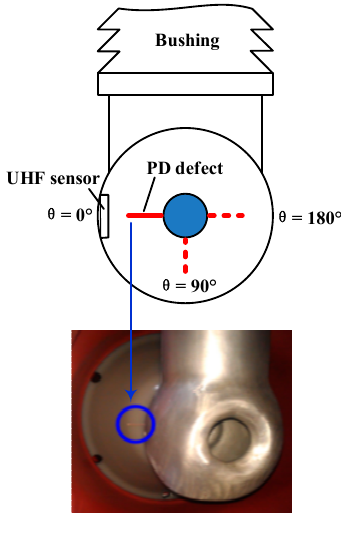
Figure 4. PD defect.